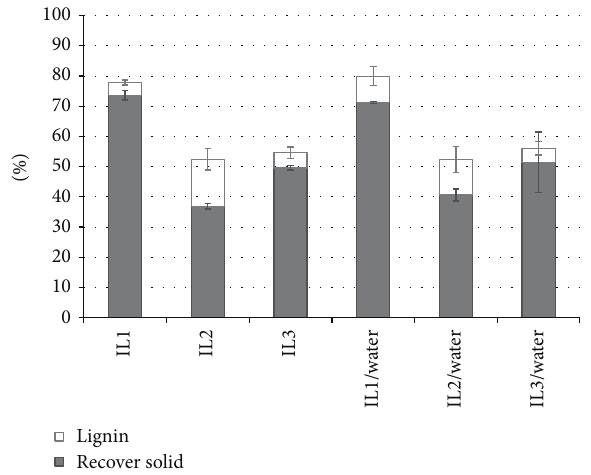
Figure 1: Yields of IL-isolated lignin and cellulose-rich materials. IL1: [BMIM]Cl/DMSO, IL2: [HMIM]Cl, and IL3: [HSO 3 -pMIM]Cl.